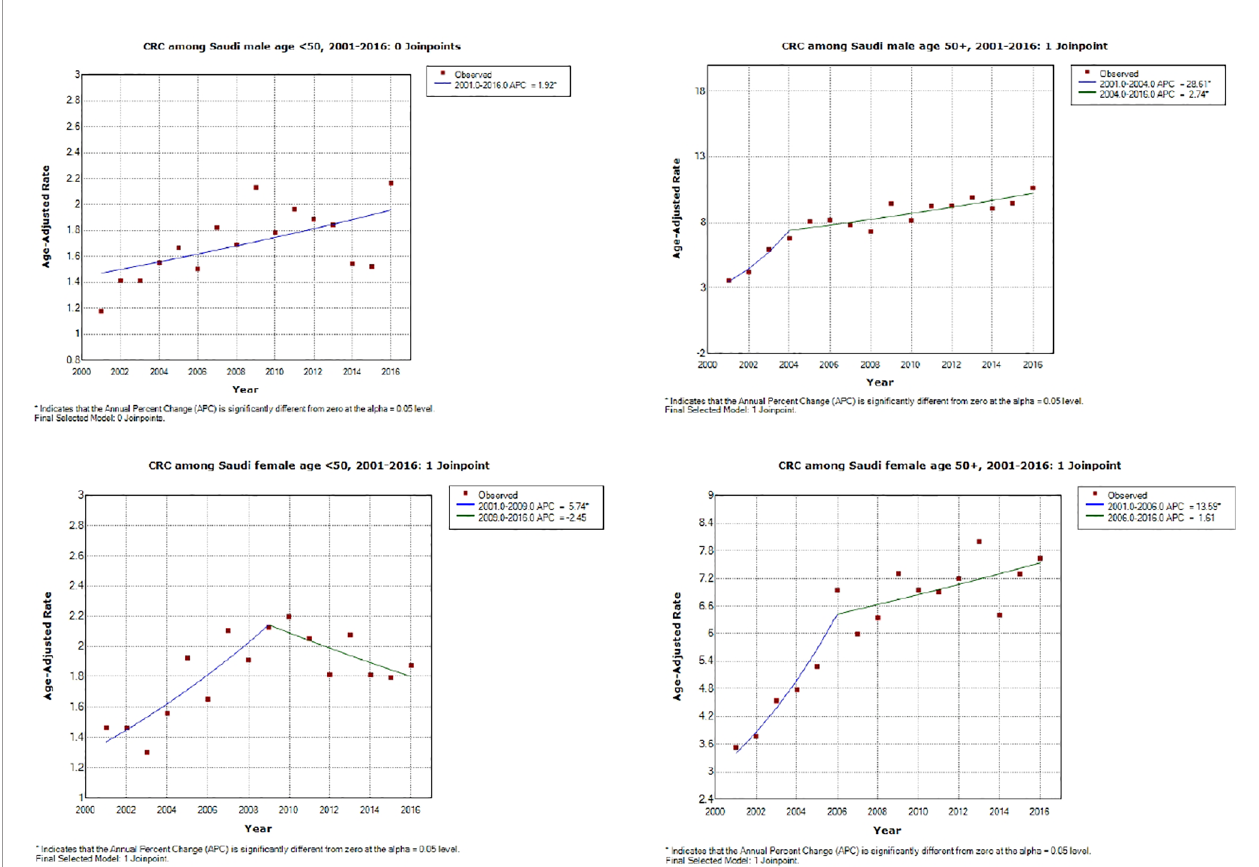
FIGURE 1 | Colorectal cancer incidence trends during the study period (2001 – 2016) by age and gender. *APC is statistically signi fi cantly different from zero using a two-sided test based on the permutation method.